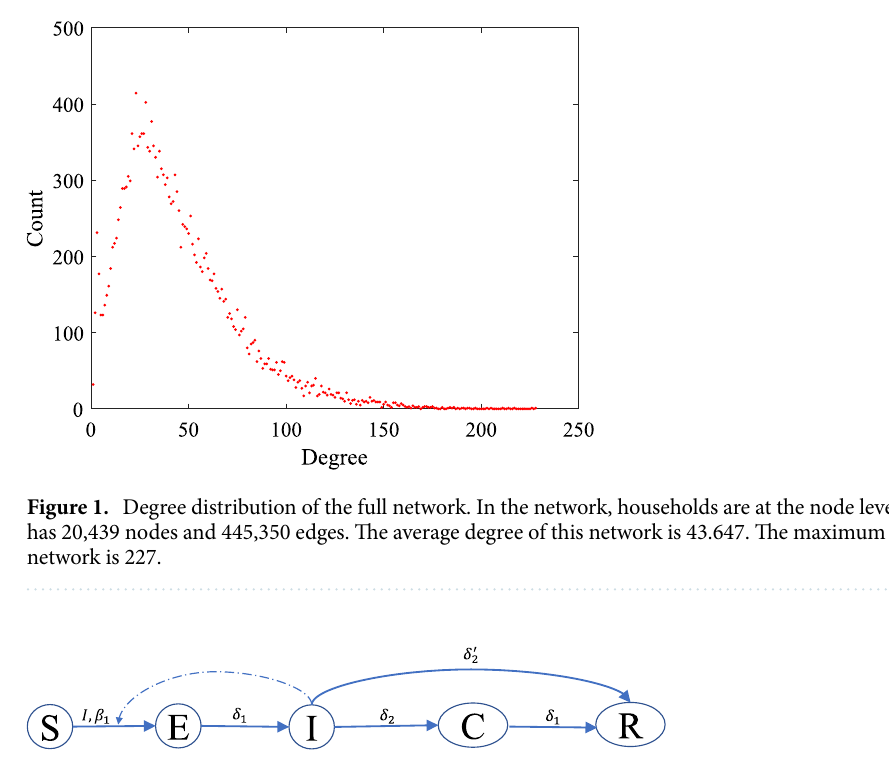
Figure 2. Node transition diagram of the susceptible-exposed-infected-confirmed (SEICR) epidemic model. This model has five compartments: susceptible ( S ), exposed ( E ), infected ( I ), confirmed ( C ), and removed ( R ) compartments. The SEICR model has five transitions (presented by solid lines): S → E (edge-based), E → I (nodal), I → C (nodal), C → R (nodal), and I → R (nodal). The infected (I) compartment is the influencer compartment of the edge-based S → E transition. The dashed line presents the influence of the I compartment on the S → E transition. We estimate R 0 and δ 2 transition rate from data. We deduce β 1 from R 0